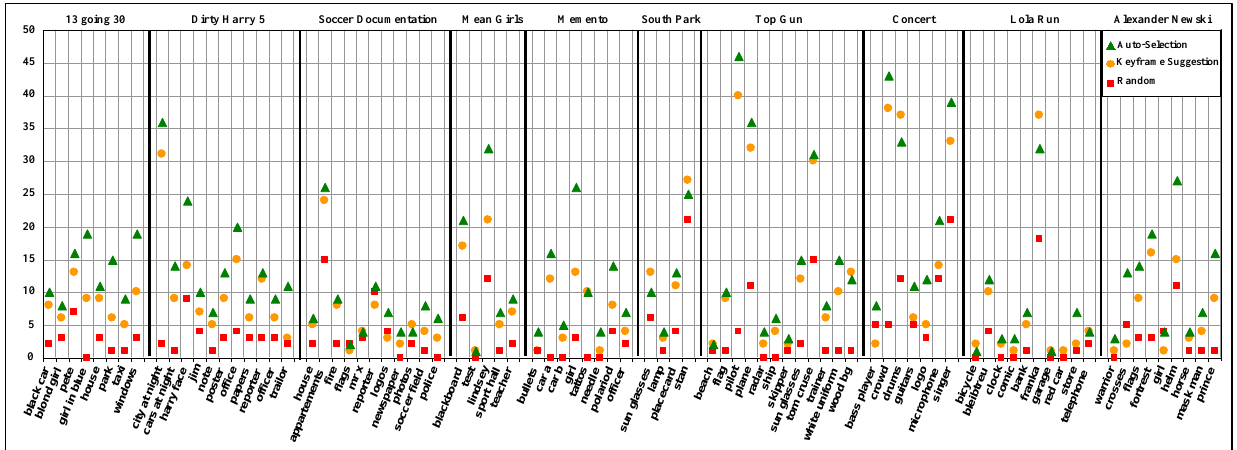
Figure 10. Number of keyframes that contain the object-of-interest within 48